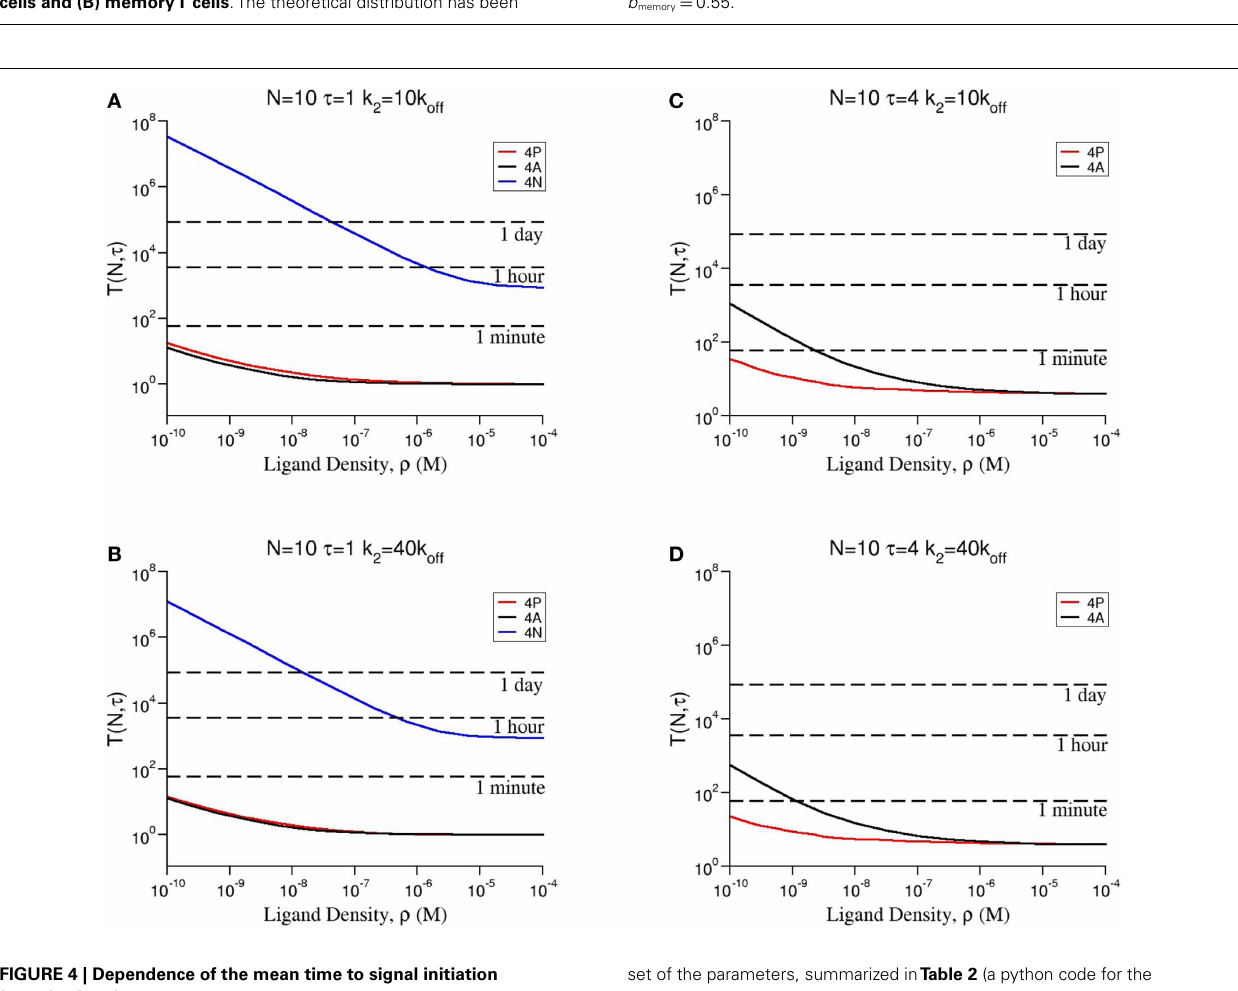
set of the parameters, summarized in Table 2 (a python code for the stochastic integration is available upon request). Units of time are seconds. All parameters are taken from Tables 1 and 2 except (A) N = 10, τ = 1 and k 2 = 10 × k off ; (B) N = 10, τ = 1 and k 2 = 40 × k off ; (C) N = 10, τ = 4 and k 2 = 10 × k off ; (D) N = 10, τ = 4 and k 2 = 40 × k off